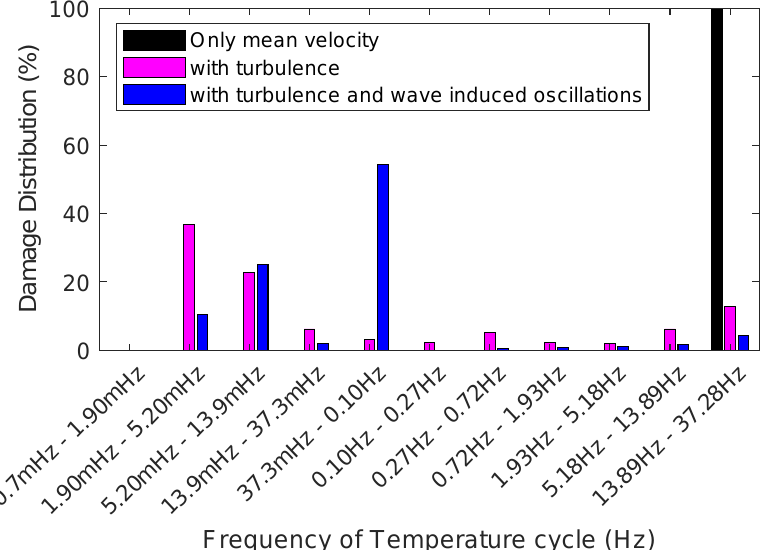
Figure 21. Percentage of total damage vs. frequency of thermal cycling, when turbulence and surface wave (Hs = 5.75 m, Tp = 11 s) is superimposed to the mean tidal velocity of 2.5